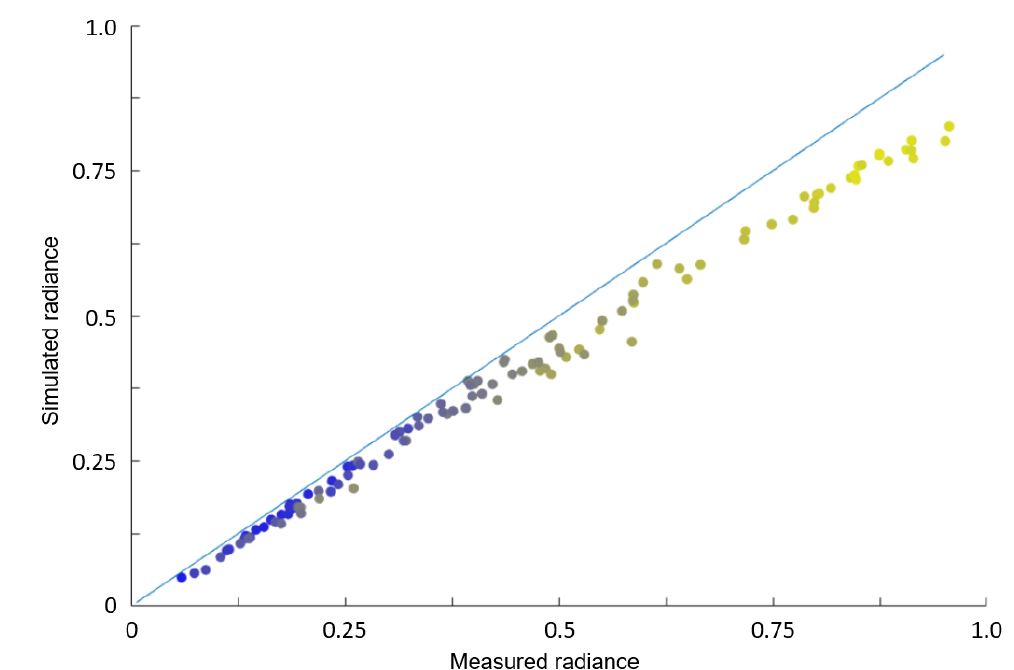
Figure 17. Comparison of real and measured radiance (scaled to [ 0,1 ] , zero and one corresponding to minimal and maximal values, respectively), showing linear correlation, although with a slope below the theoretically expected slope of 1. Each data point represents the compared mean values of one picture. The colors indicate the solar zenith angle, and each dot represents a triangle (yellow=high, blue=low, ranging from 0 to 90 degrees), Image ID FC21B0007807-26232214089F1B.FIT . To improve readability, only deviations are detected for low zenith angles, thus indicating systematic deviations of the BDRF, especially for shallow illumination conditions. This might be a result of e.g., surface roughness not included in the Hapke BDRF used here.